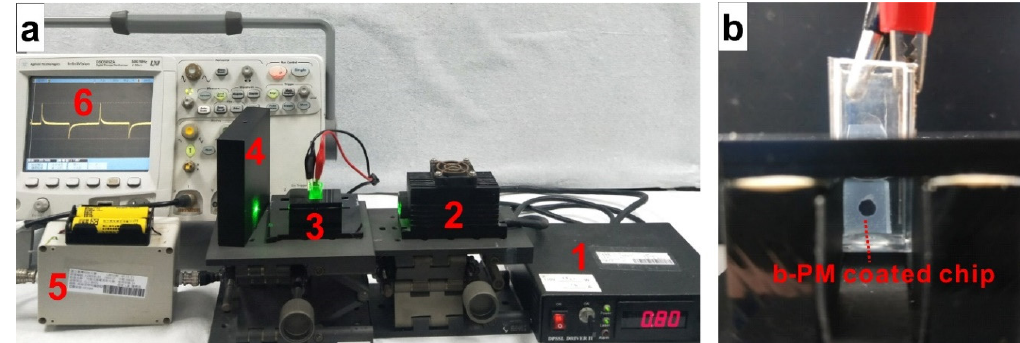
Figure 1. Photos of ( a ) the equipment setup for photocurrent measurement and ( b ) the detection cell. In ( a ), 1: laser power controller; 2: 532 nm CW laser; 3: detection cell and the holder; 4: beam dump; 5: current amplifier; 6: oscilloscope. In ( b ), a b-PM coated chip and a platinum bar are positioned inside a cuvette and then connected to the current amplifier through the black and red wires, respectively.